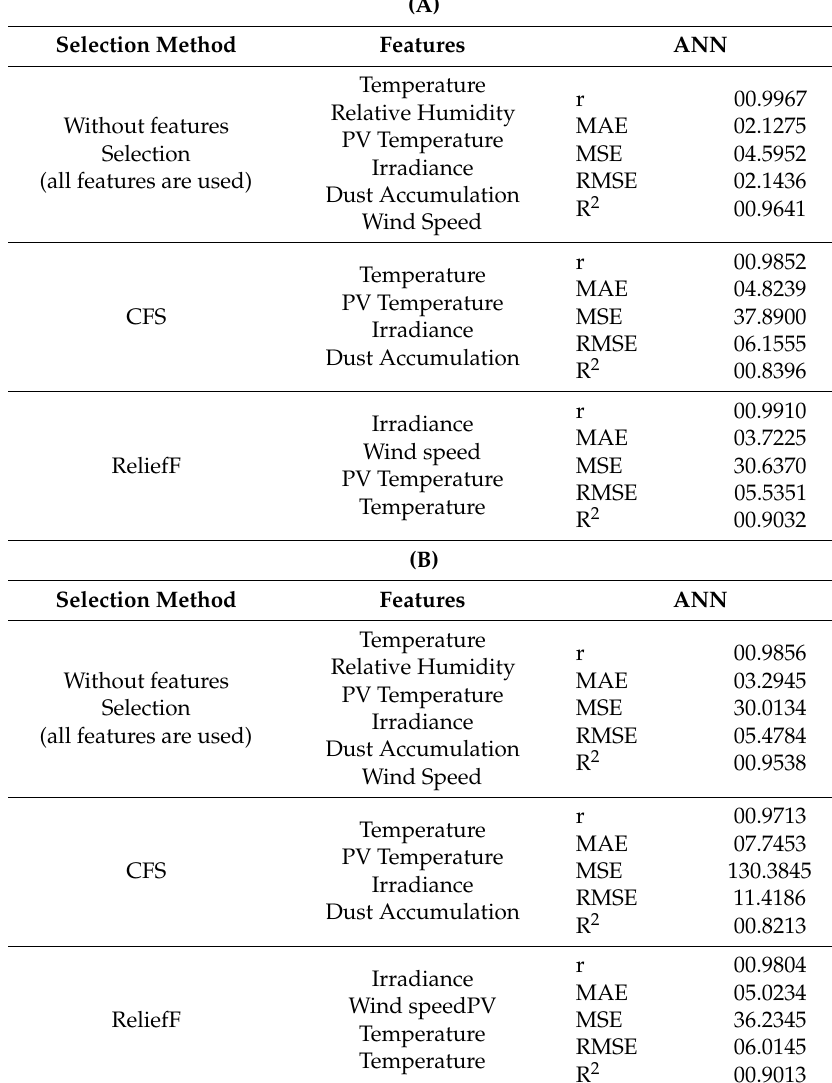
Table 7. (A) Performance comparison between the various ANN techniques (validation phase). (B) Performance comparison between the various ANN techniques (testing